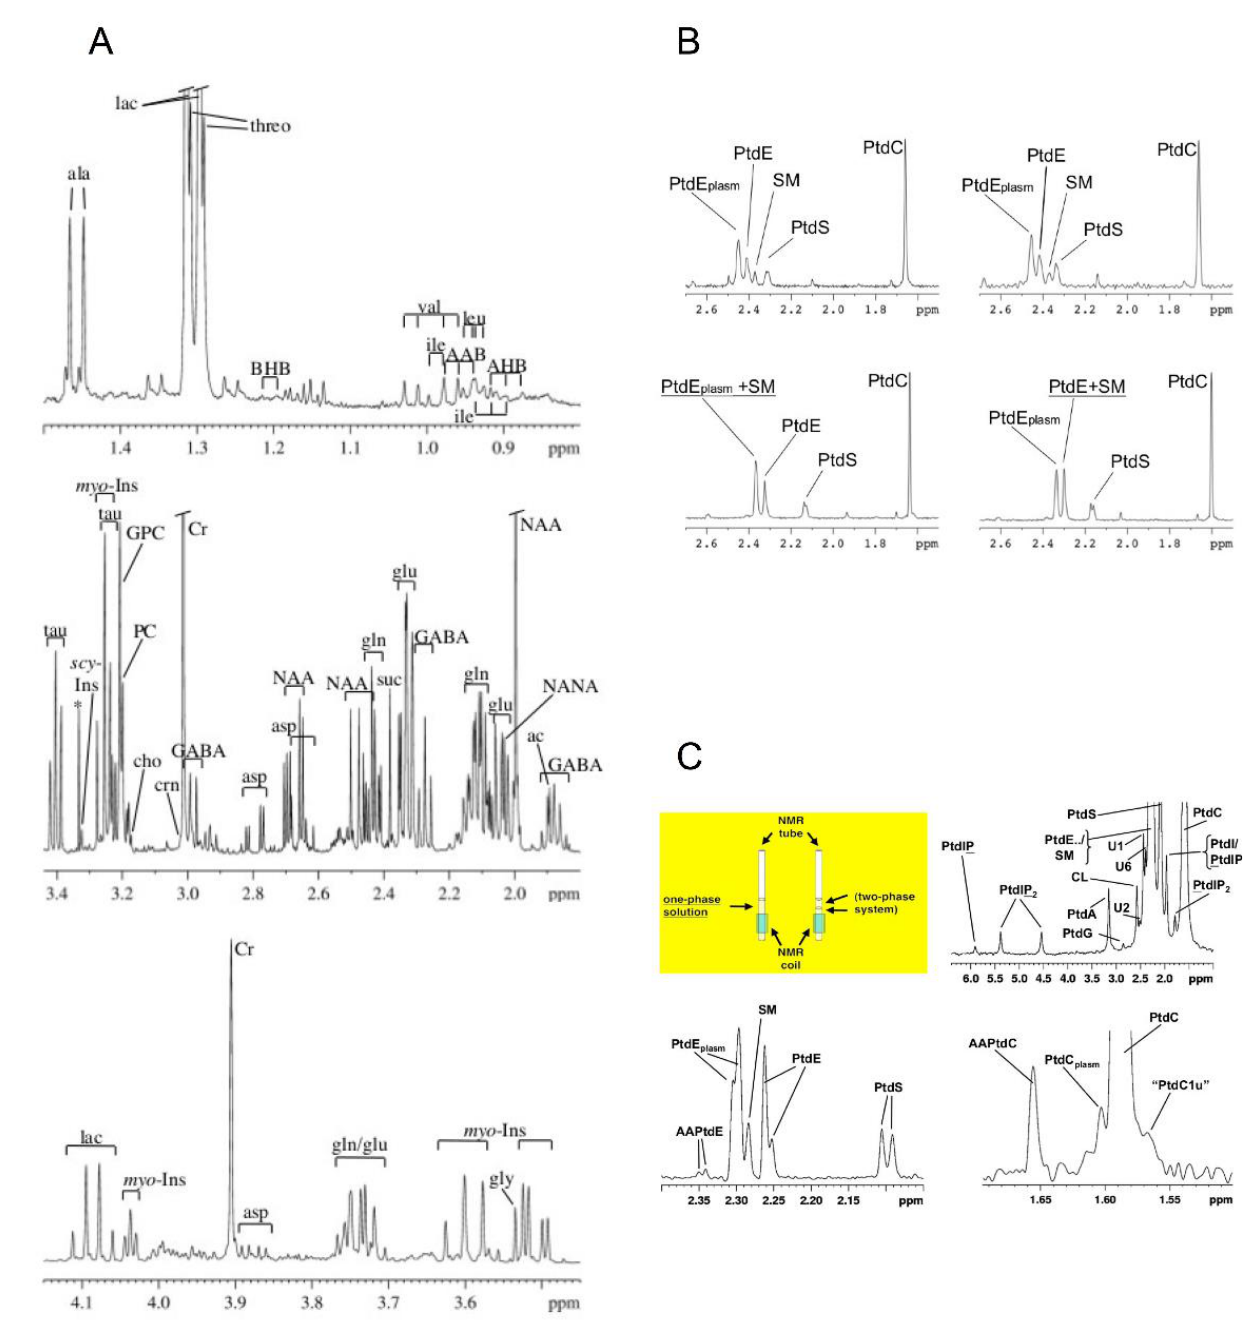
Figure 2. 1 H-NMR spectroscopy (400 MHz, 9.4 T) of the aqueous phase of a brain tissue extract from a female Lewis rat. Panel ( A ). Subregions of a typical 1 H-NMR spectrum (400 MHz, 9.4 T) of the aqueous phase of a brain tissue extract from a female Lewis rat. All three panels demonstrate the extremely high resolution obtainable using the protocol presented in the paper cited below. Neither